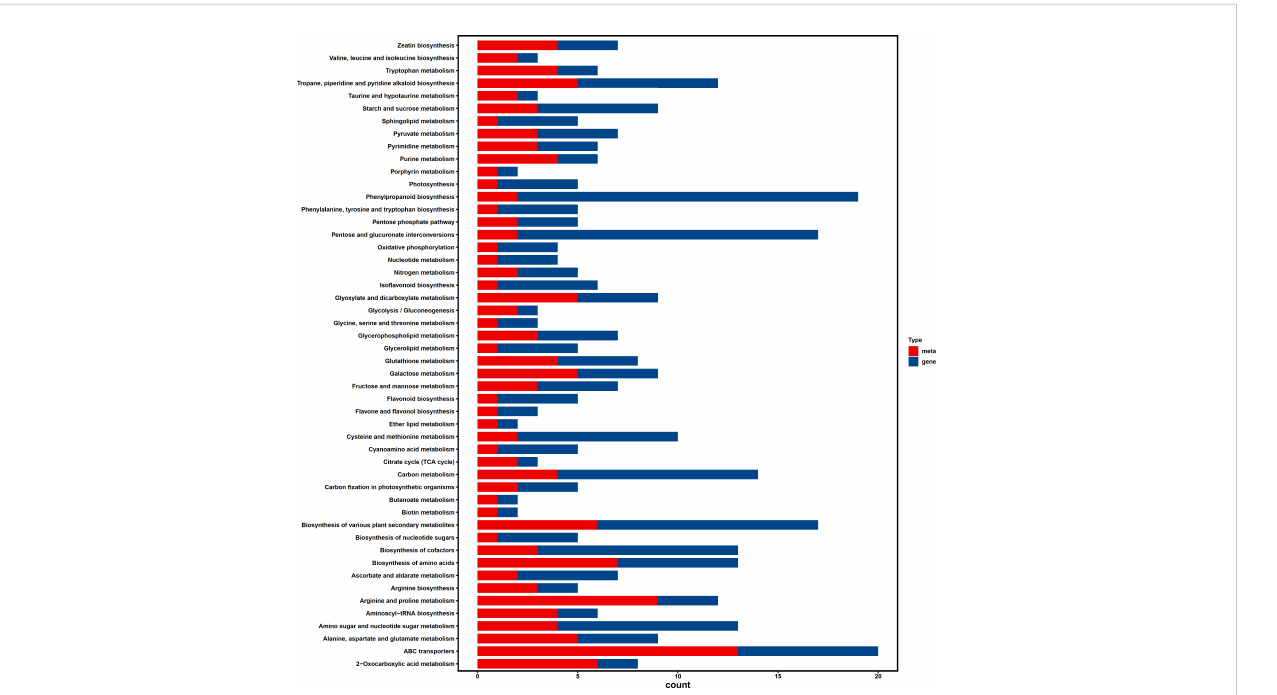
FIGURE 6 Integrated analysis of transcriptome and metabolome. Different genes and metabolites enrichment bar chart. The y-axis is the number of enriched genes or metabolites. The x-axis represents the enriched pathways. Red color represents the different metabolites, blue colors represents different genes.